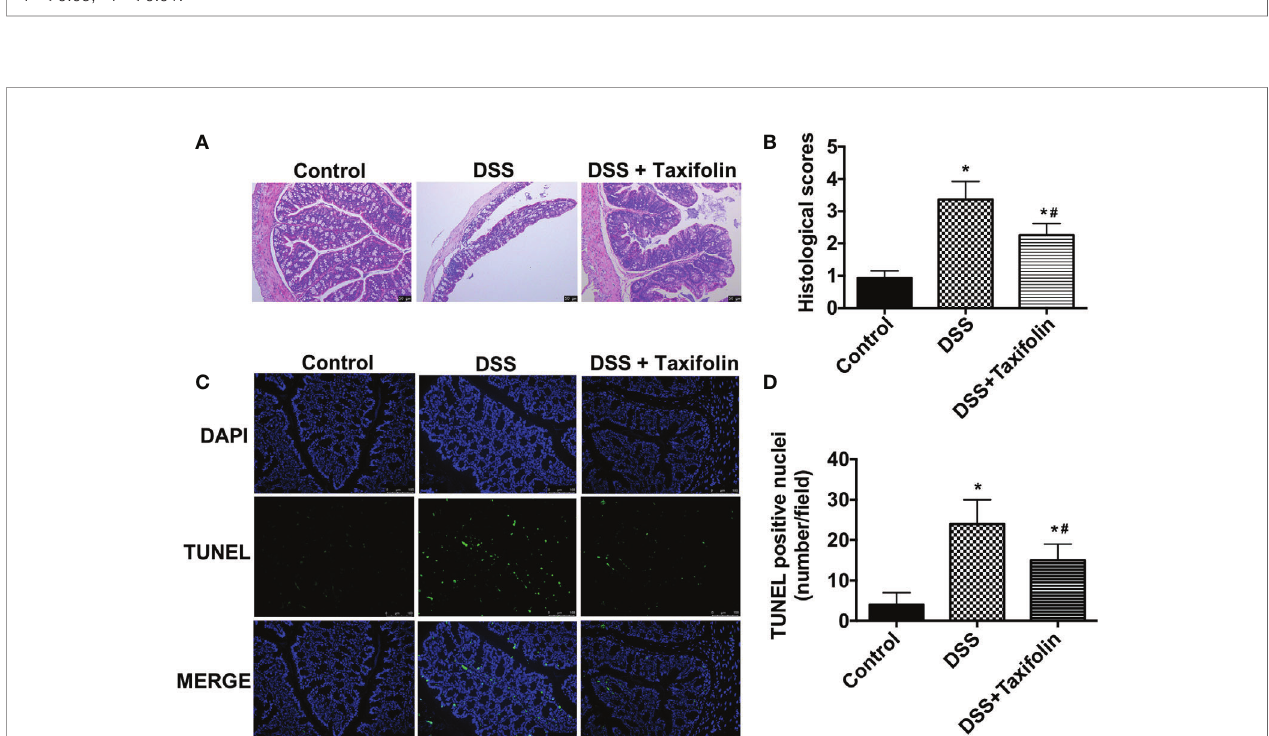
FIGURE 2 | Oral administration of taxifolin alleviated DSS-induced colon histological changes of mice. (A) The H&E staining of the colon morphology of mice. The bars represent 50 m m. (B) Histological scoring was obtained from the H&E results of colon; (C) The fl uorescent micrographs of TUNEL (green) and DAPI (blue) staining of colon. The bars represent 100 m m. (D) Quantitation of TUNEL positive nuclei per fi eld obtained from fl uorescent micrographs. Data were expressed as means ± SEM ( n = 10). * P < 0.05 vs . control group, # P < 0.05 vs . DSS group.